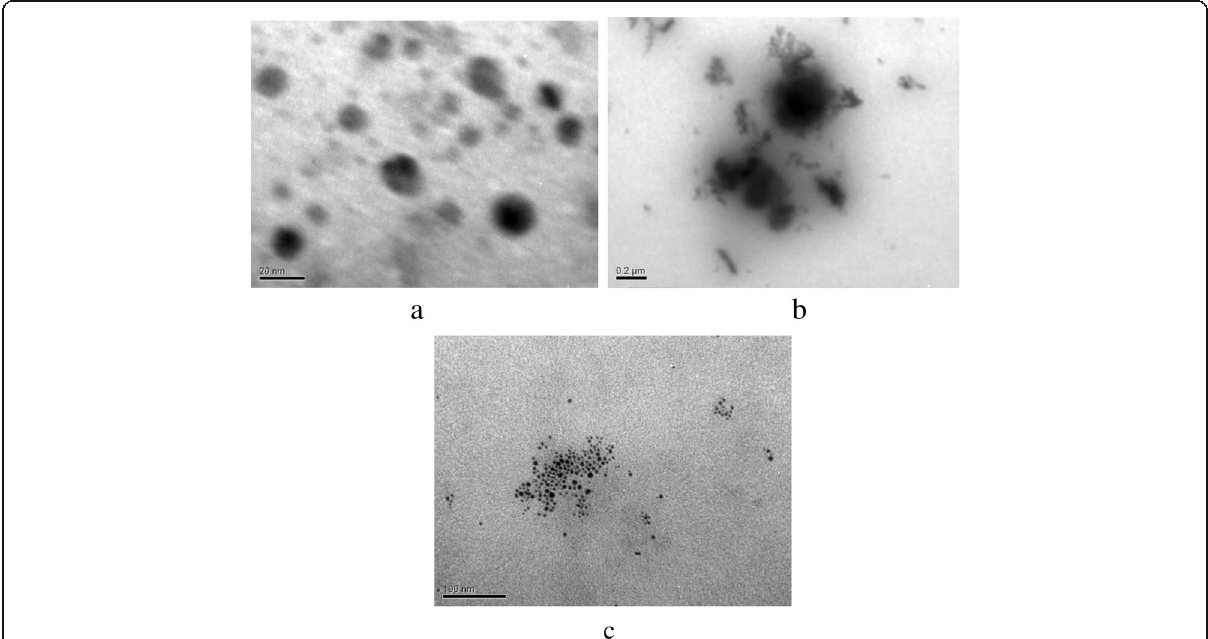
Fig. 2 TEM images of ZHP ( a , b ) and HZD c nanoparticles in the cation ( a , b ) and anion ( c ) exchangers of series 1 before ( a , c ) and after ( b ) treatment with glycerol. Non-aggregated nanoparticles ( a , c ) and their aggregates ( b ) are seen